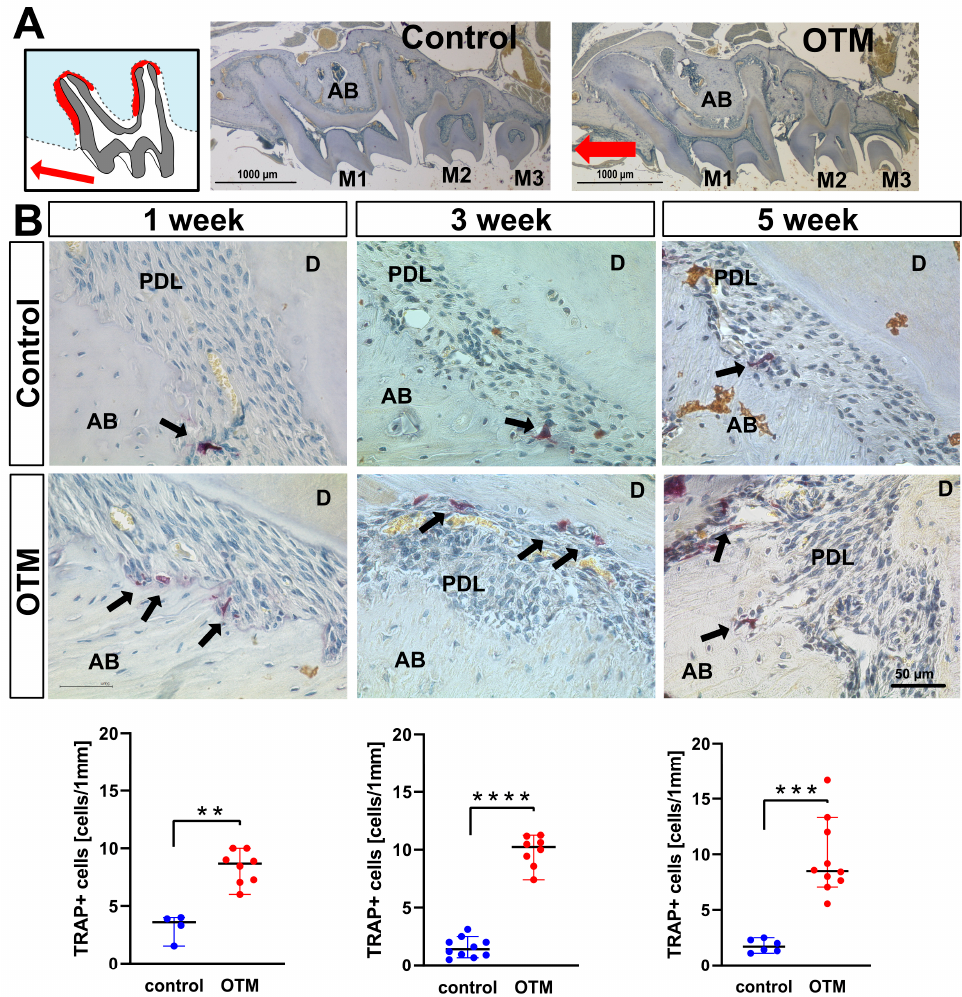
Figure 5. Increase of TRAP-positive cells corresponding to osteoclastogenesis at the OTM side with NiTi coil spring compared to the untreated contralateral jaw side. ( A ) Schematic picture of compression zones’ M1 distal roots (red) and overview pictures of sagittal sections of maxillary mice, contralateral control side and orthodontic tooth movement (OTM) side. ( B ) Focusing on the compression zones of M1 distal roots, the number of TRAP-positive osteoclast/odontoclast-like cells (black arrows) was counted on the OTM side and CC. On CC sides the baseline number of TRAP-positive cells is not significantly different, while on the OTM side, it exhibits a significant increase at all time points (** p < 0.01, **** p < 0.0001, and *** p < 0.001, respectively). Two micrographs of molars were randomly selected from at least two animals for histological analysis.